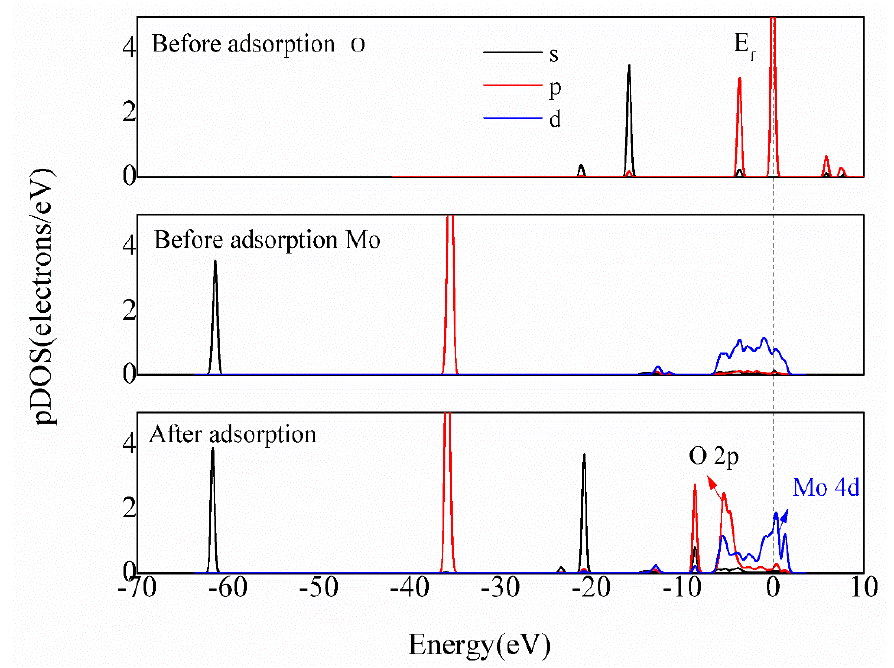
Figure 14. PDOS results of O and Mo before and after CaOH + adsorbed on molybdenite (100) sur- face.